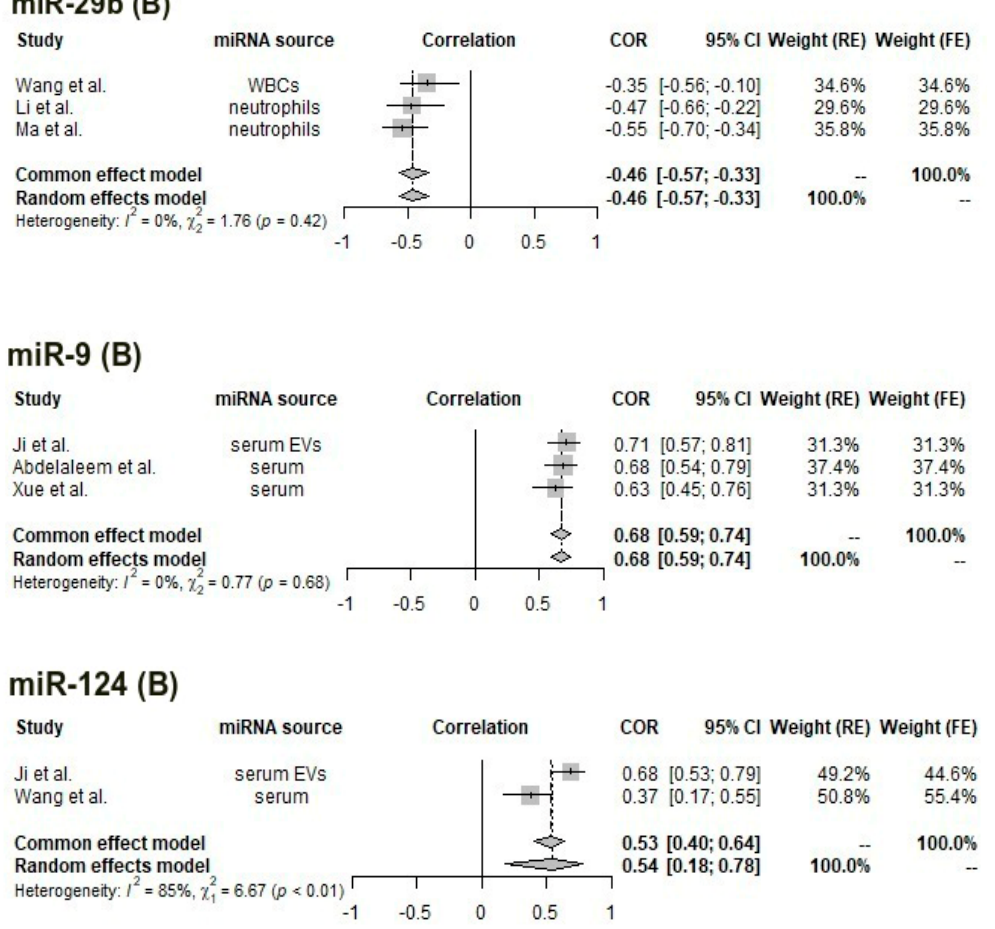
Figure 2. Forest plot for the correlation between the concentration of let-7i, miR-9, miR-21, miR-29b, miR-124, miR-124-3p, and NIHSS score; in certain cases, we address separately all reported studies ( A ) and ( B ) only studies with reported same miRNA source. References: miR-29b: [47,70,71,75]; let-7i: [54,56]; miR-9: [60,66,72,73]; miR-21: [68,69]; miR-124-3p: [61,63]; miR-124: [57,60,74].